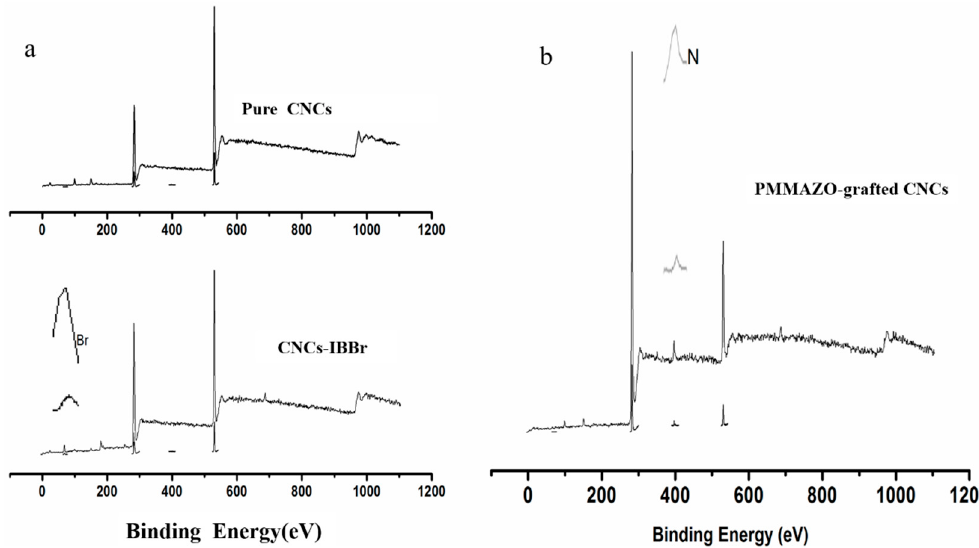
Figure 3. The low-resolution map of pure CNCs, CNCs-IBBr ( a ), and PMMAZO-grafted CNCs ( b ).